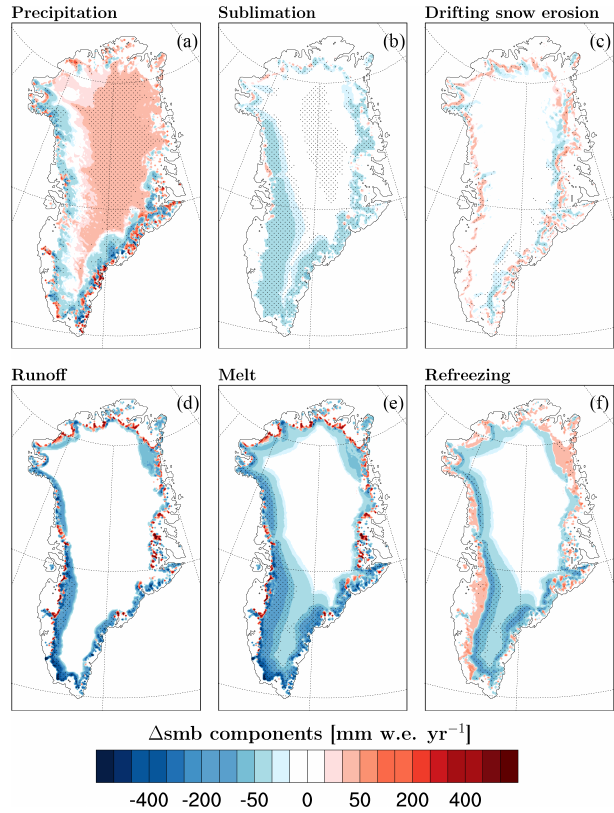
Figure 7. Difference in SMB components (mmw.e.yr − 1 ) between RACMO2.3p2 and RACMO2.3p1 averaged for the period 1958– 2015. Areas showing significant difference are stippled: the differ- ence exceeds 1 standard deviation of the difference between the two model